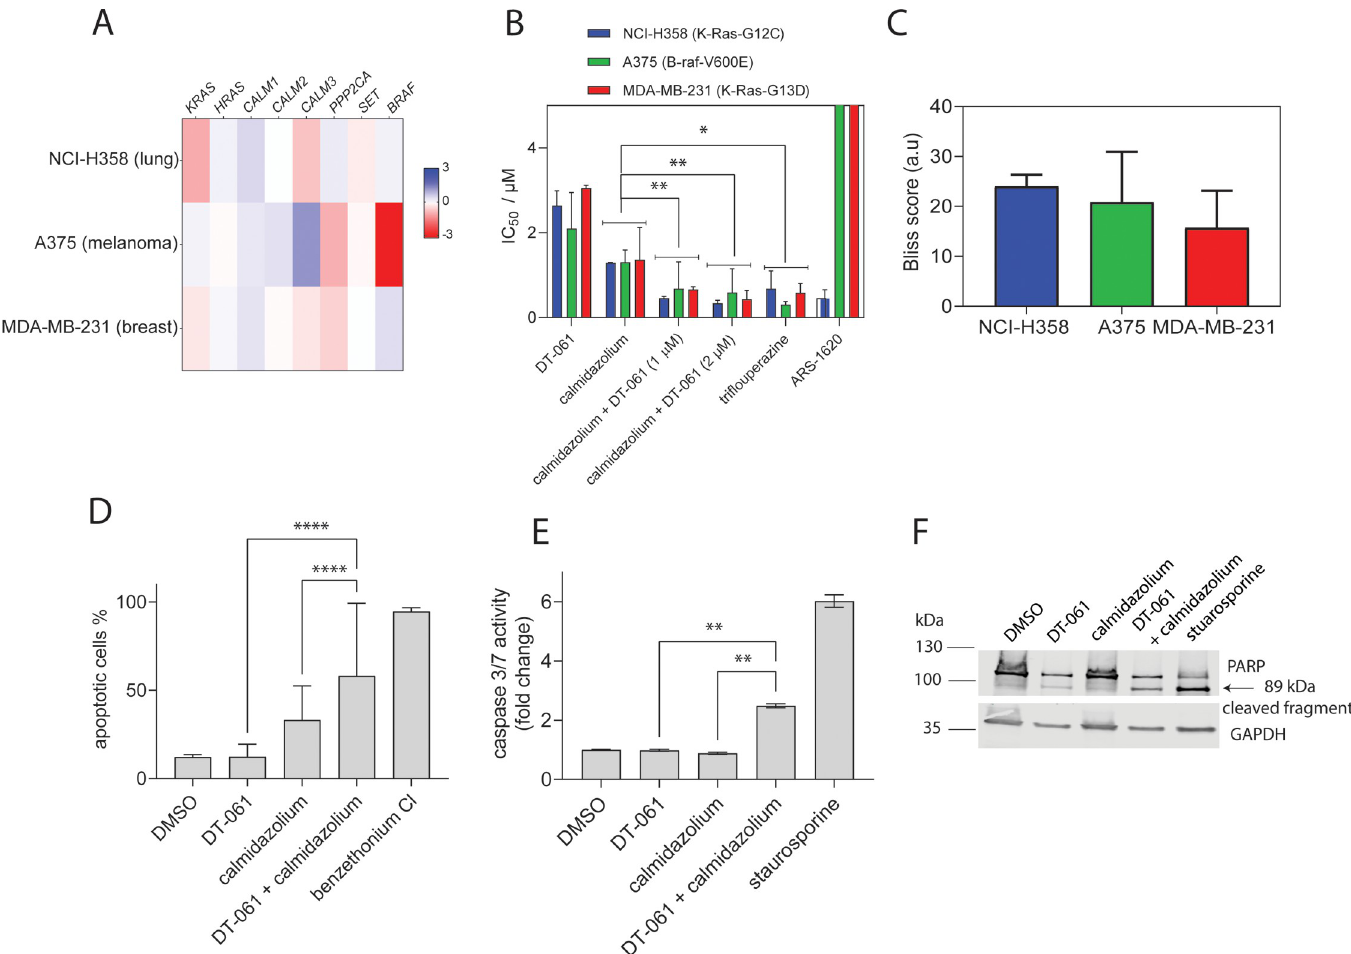
Fig 1. Cellular assessment of CaM inhibitors and PP2A activators suggests their synergistic potential against Ras pathway dependent cancer cell lines. (A) Heatmap of ATARiS gene sensitivity scores of two KRAS dependent cell lines (NCI-H358 and MDA-MB-231) and a BRAF dependent cell line (A375). Negative values (shaded red) indicate sensitivity of the cell line proliferation to the knockdown of shown genes, whereas positive scores (shaded blue) indicate insensitivity. (B) IC 50 values for indicated compounds in Ras pathway mutant cell lines NCI-H358, MDA-MB231 and A375 grown as 3D spheroids under serum free conditions. Compounds were tested either as single agent at a concentration range of 0.2 μ M– 10 μ M (calmidazolium), 0.6 μ M– 40 μ M (DT-061), 0.2 μ M– 40 μ M (trifluoperazine) and 0.6 μ M– 40 μ M (ARS-1620) or in combination, applying the whole concentration range of calmidazolium combined with 1 μ M or 2 μ M of DT-061, as indicated. Data represent mean values ± SD, n = 2. Statistical comparisons were done using the average values across all three cell lines. (C) Bliss synergism scores for combinatorial effects of calmidazolium and DT-061 in KRAS- or BRAF-mutant cancer cell lines. Data represent mean values ± SD, n = 2. Positive scores indicate synergistic drug interactions whereas negative scores would denote antagonistic drug interactions. A score of zero would indicate no antagonistic or synergistic effect. ( D ) Flow cytometric analysis of apoptosis in MDA-MB-231 cells. MDA-MB-231 cells were treated with DT-061 (10 μ M) or calmidazolium (5 μ M) or their combination for 24 h and then labelled with Annexin V-FITC and 7AAD. Benzethonium chloride and DMSO treated cells were used as positive and negative controls, respectively, for setting the gates. Percentage of total apoptotic cells (early and late stage) from two biological repeats (mean ± SD) is presented. Statistical analysis was performed using Fisher’s exact test comparing the total number of viable and apoptotic cells from two biological repeats. ( E ) Effect of inhibitors on cellular apoptosis studied using Caspase-3/7Glo assay. MDA-MB-231 cells were treated with DT-061 (5 μ M), calmidazolium (5 μ M), combination of DT-061 and calmidazolium (5 μ M each), and staurosporine (1 μ M) for 24 h. The caspase-3/7 activity was measured as a luminescence read-out and normalized to the vehicle control, 0.05% (v/v) DMSO. Data represent mean values ± SD, n = 2. ( F ) Western blot analysis of PARP-cleavage activity in MDA-MB-231 cells treated with DMSO (0.2% (v/v)), DT-061 (20 μ M), calmidazolium (5 μ M), combinations of DT-061 (10 μ M) and calmidazolium (5 μ M), and staurosporine (1 μ M) for 24 h. GAPDH detection was used as loading control.